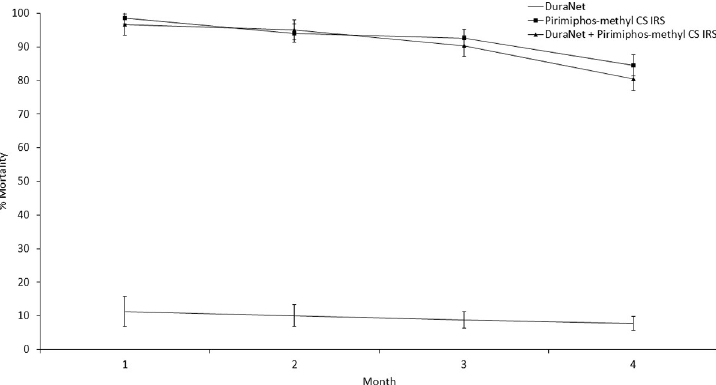
Fig 1. Monthly mortality rates of wild, free-flying pyrethroid-resistant Anopheles gambiae sensu lato entering experimental huts with pirimiphos-methyl CS IRS applied alone and in combination with DuraNet 1 in Cov è , southern Benin. Mortality was cumulated over successive months. Error bars represent 95% CI.